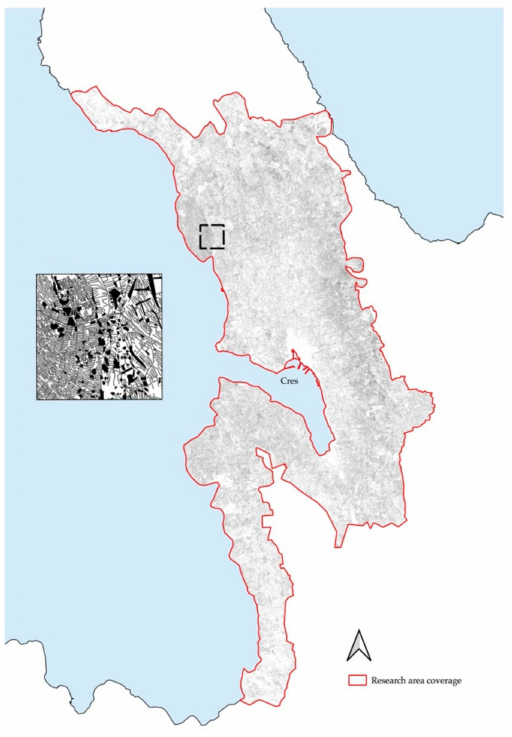
Figure 17. GIS vectorisation of all of the dry stone walls within the Cres olive grove research